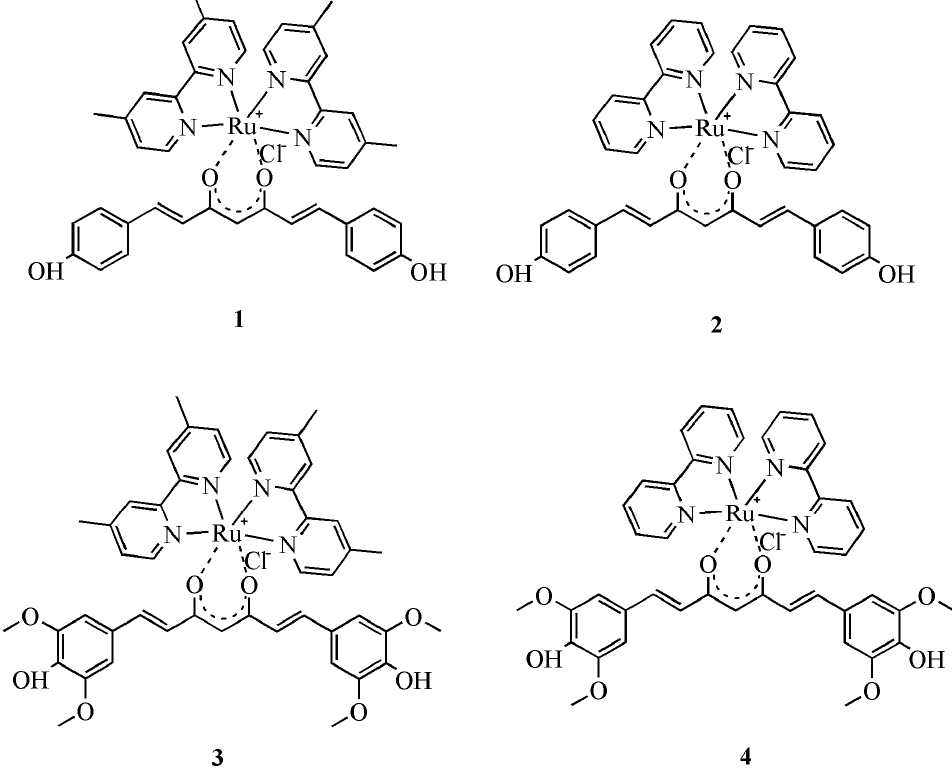
Figure 2. Structures of prepared ruthenium complexes 1 – 4 .